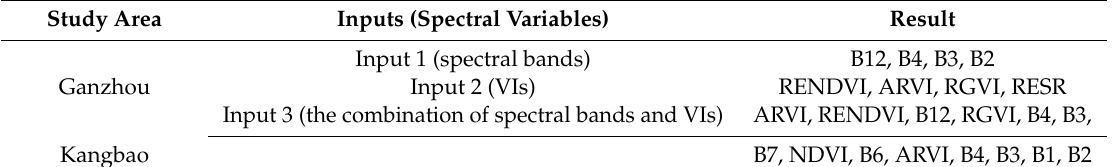
Table 3. The selected spectral variables for estimating LAI for three set inputs of predictors. Study